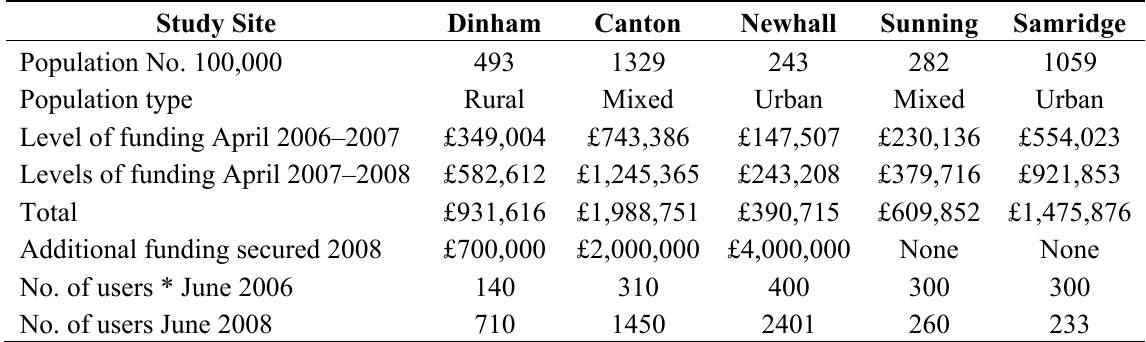
Table 1. Telehealthcare implementation across our case